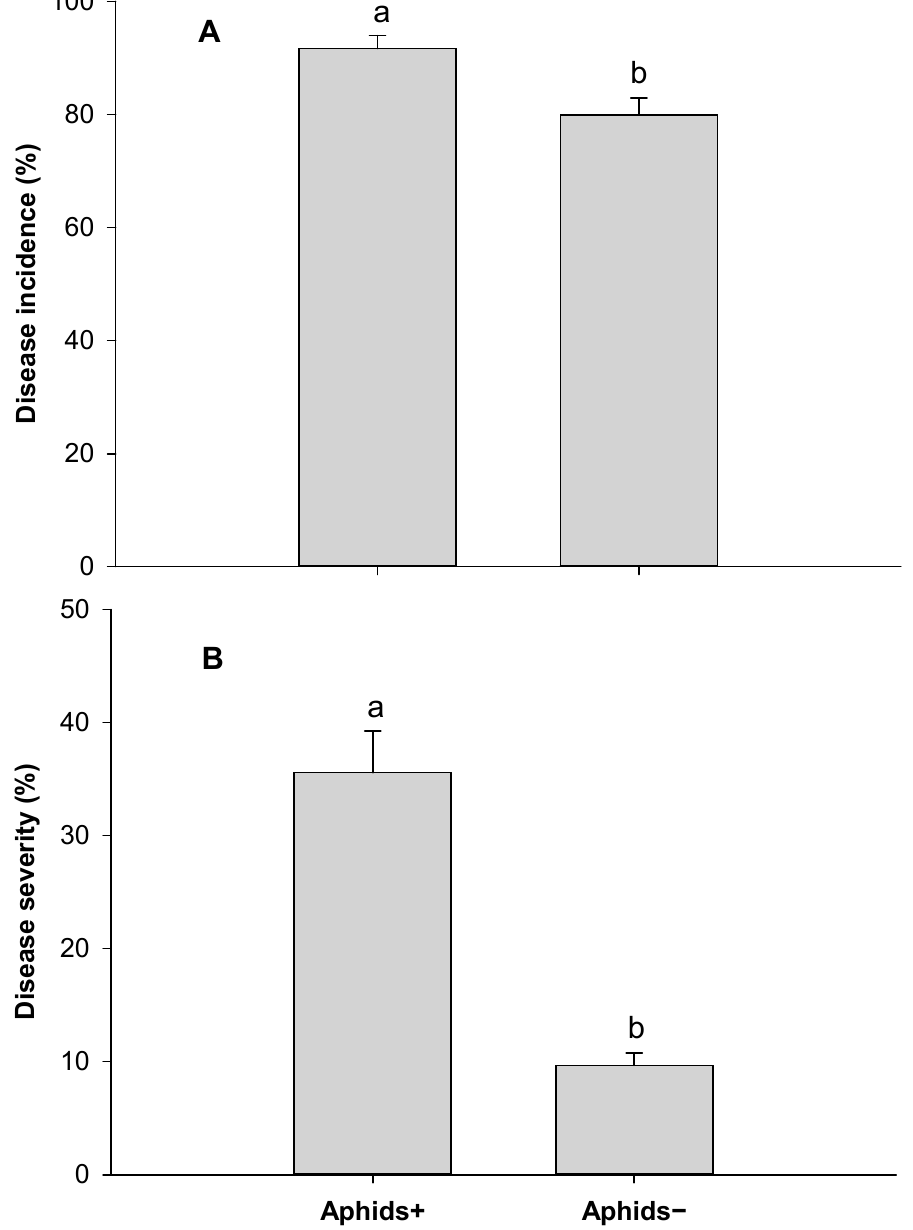
Figure 2. Stagonospora nodorum blotch disease 14 days after inoculation: Disease incidence ( A ) and severity ( B ) on aphid ( Rhopalosiphum padi) infested (Aphids+) and non-infested (Aphids − ) wheat plants from experiment 1. Error bars are standard error of the mean values and bars with different letters are different according Tukey’s test at p = 0.05.